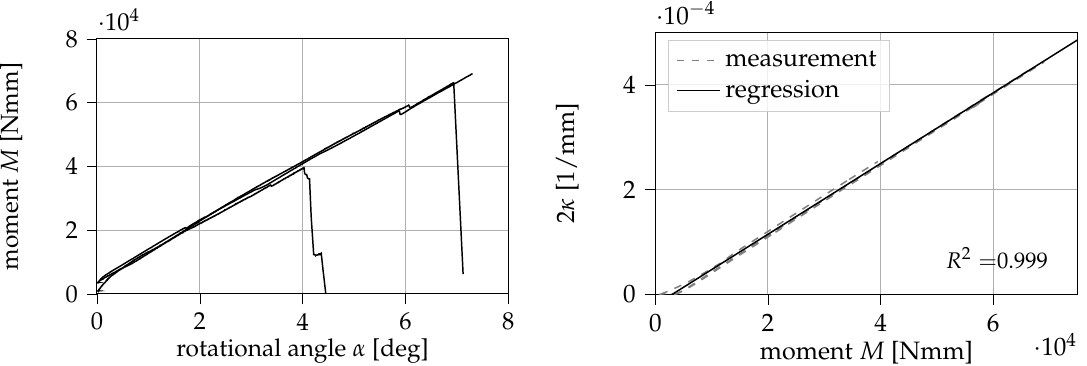
Figure 10. Measured moment M y over the rotational angle α ( left ) and linear regression between the curvature 2 κ and the measured moment M y ( right ) obtained with three